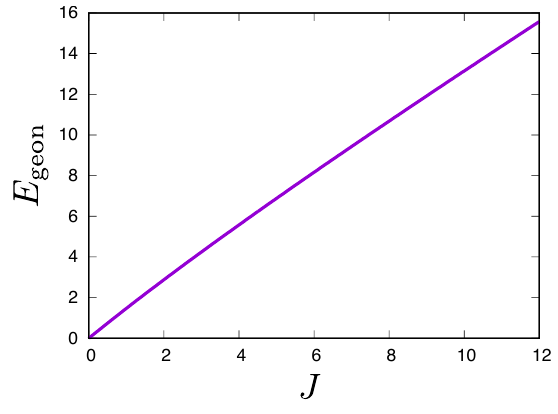
Figure 1 . Energy of geons E geon as a function of the angular momentum J .